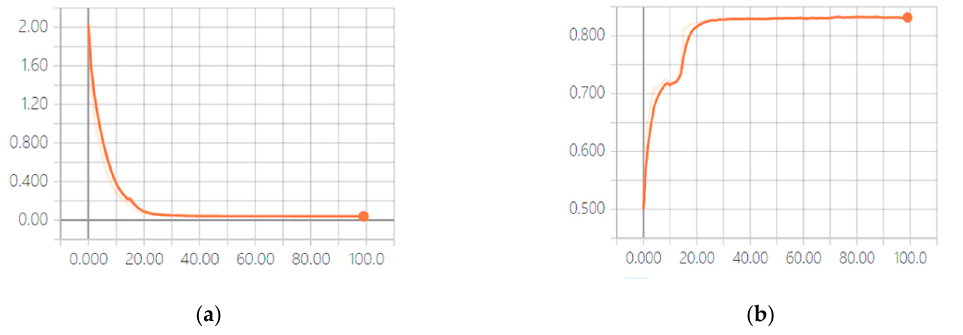
Figure 7. Training and test curve on NTU dataset (cross-subject): ( a ) training loss curve; ( b ) test accuracy curve.